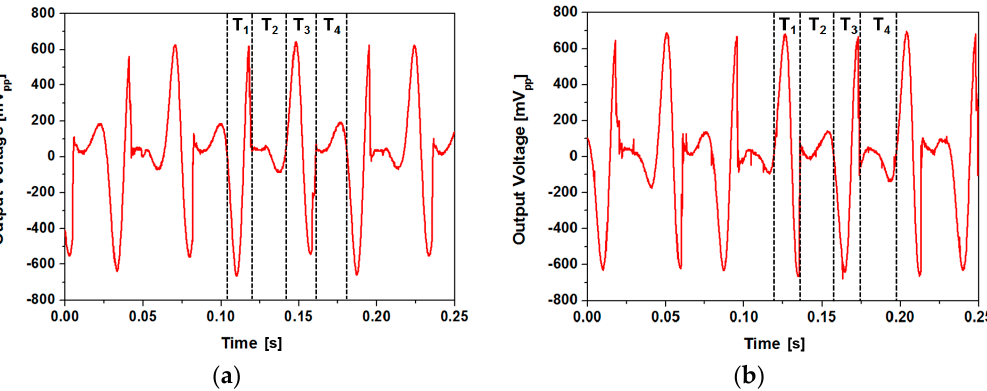
Figure 13. Open circuit voltage waveforms (devices with ferrofluid): ( a ) type 1; ( b ) type 2.